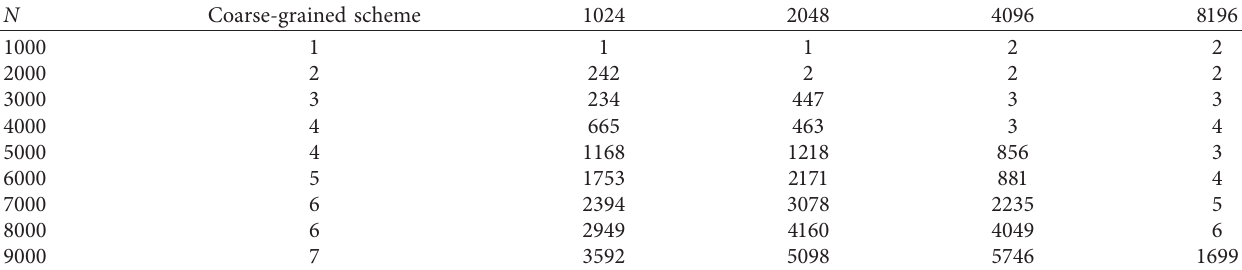
Table 3: Performance of the CDP-based scheme. Threshold from 1k to 8k. N